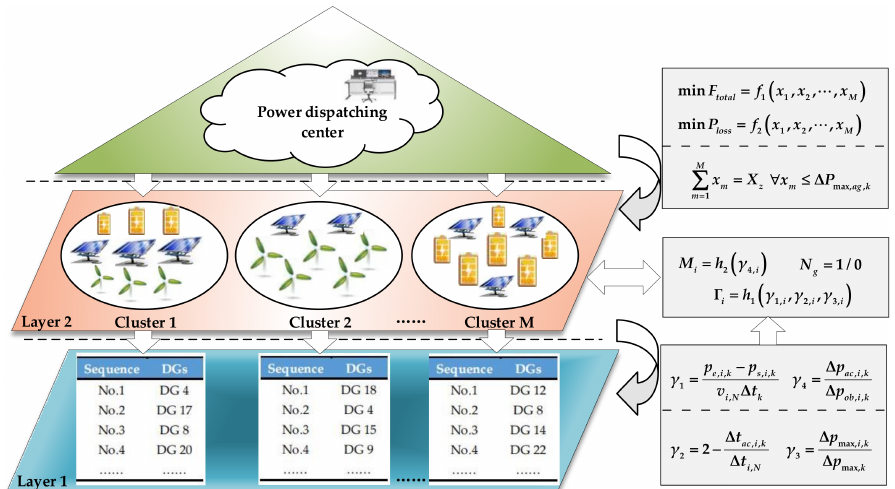
Figure 4. Two-layer peak shaving